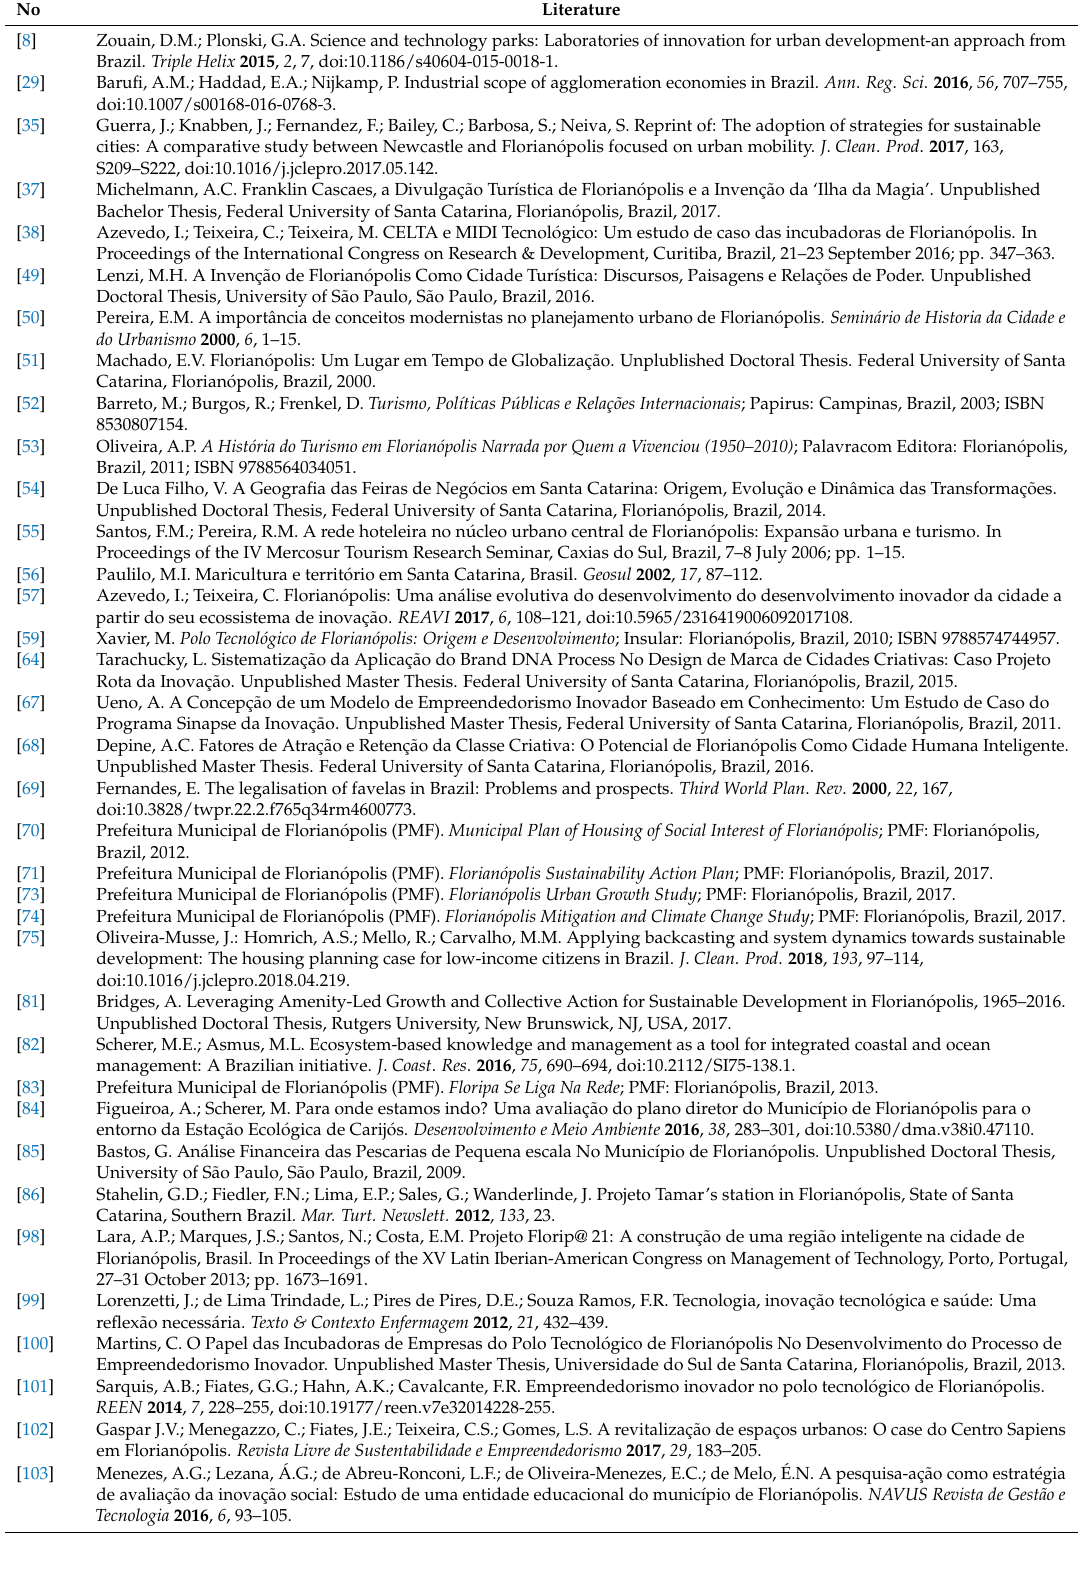
Table A2. Reviewed